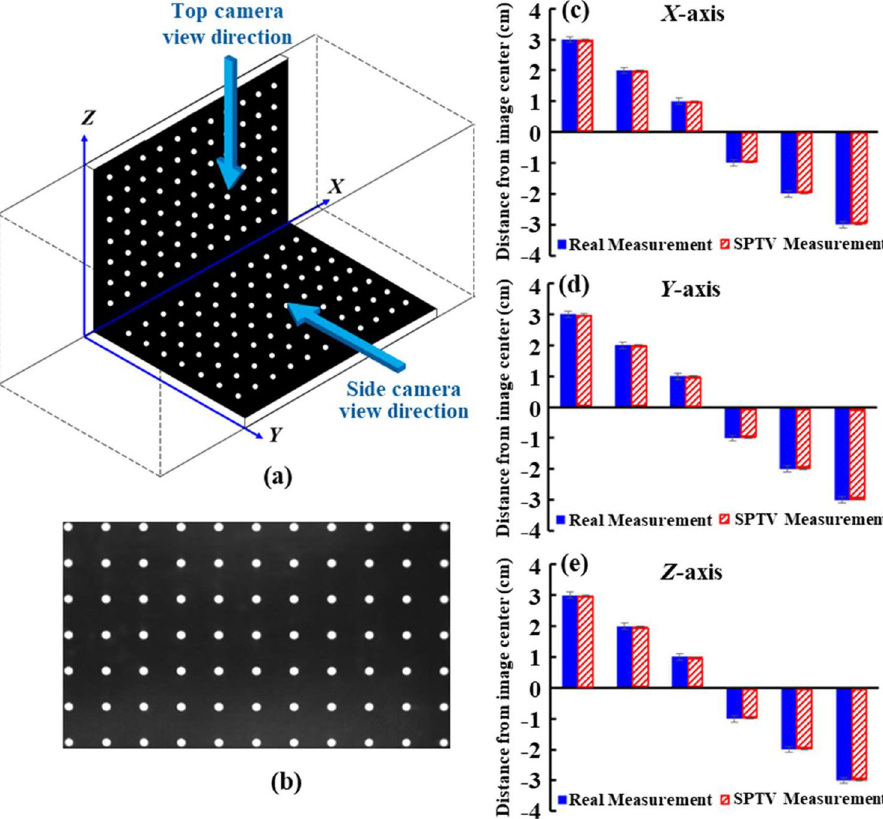
Figure 4. System calibration: ( a ) L -shape position calibration platform, ( b ) the camera-view, as well as the calibrated SPTV precision along the ( c ) X -, ( d ) Y -, and ( e ) Z -axis with respect to control